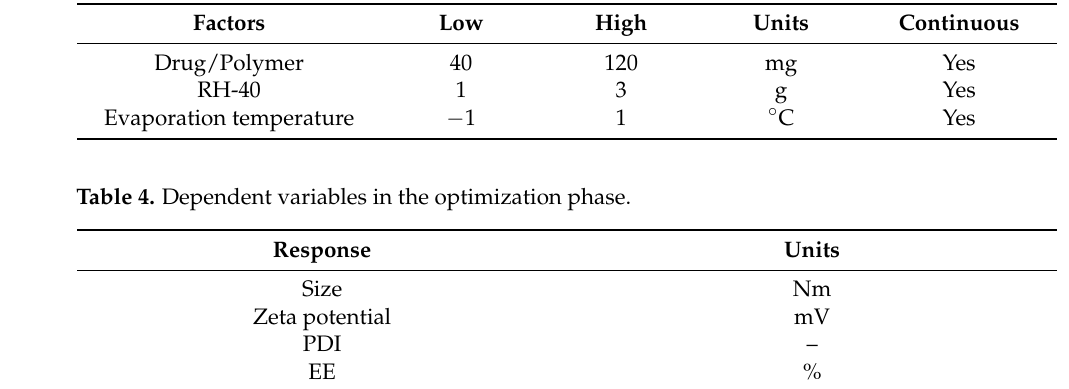
Table 3. Independent variables in the optimization of glibenclamide ME/EA NPs.